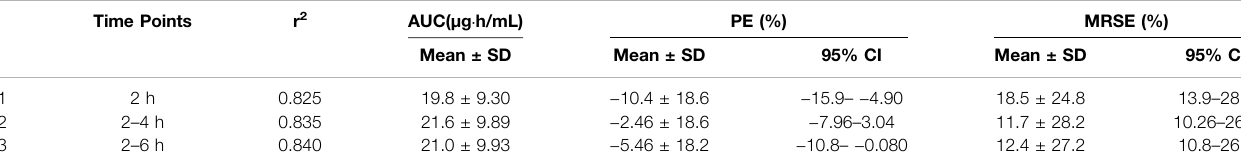
TABLE 4 | Prediction performance of the selected limited sampling strategy of INH AUC 0 – 24h . Time